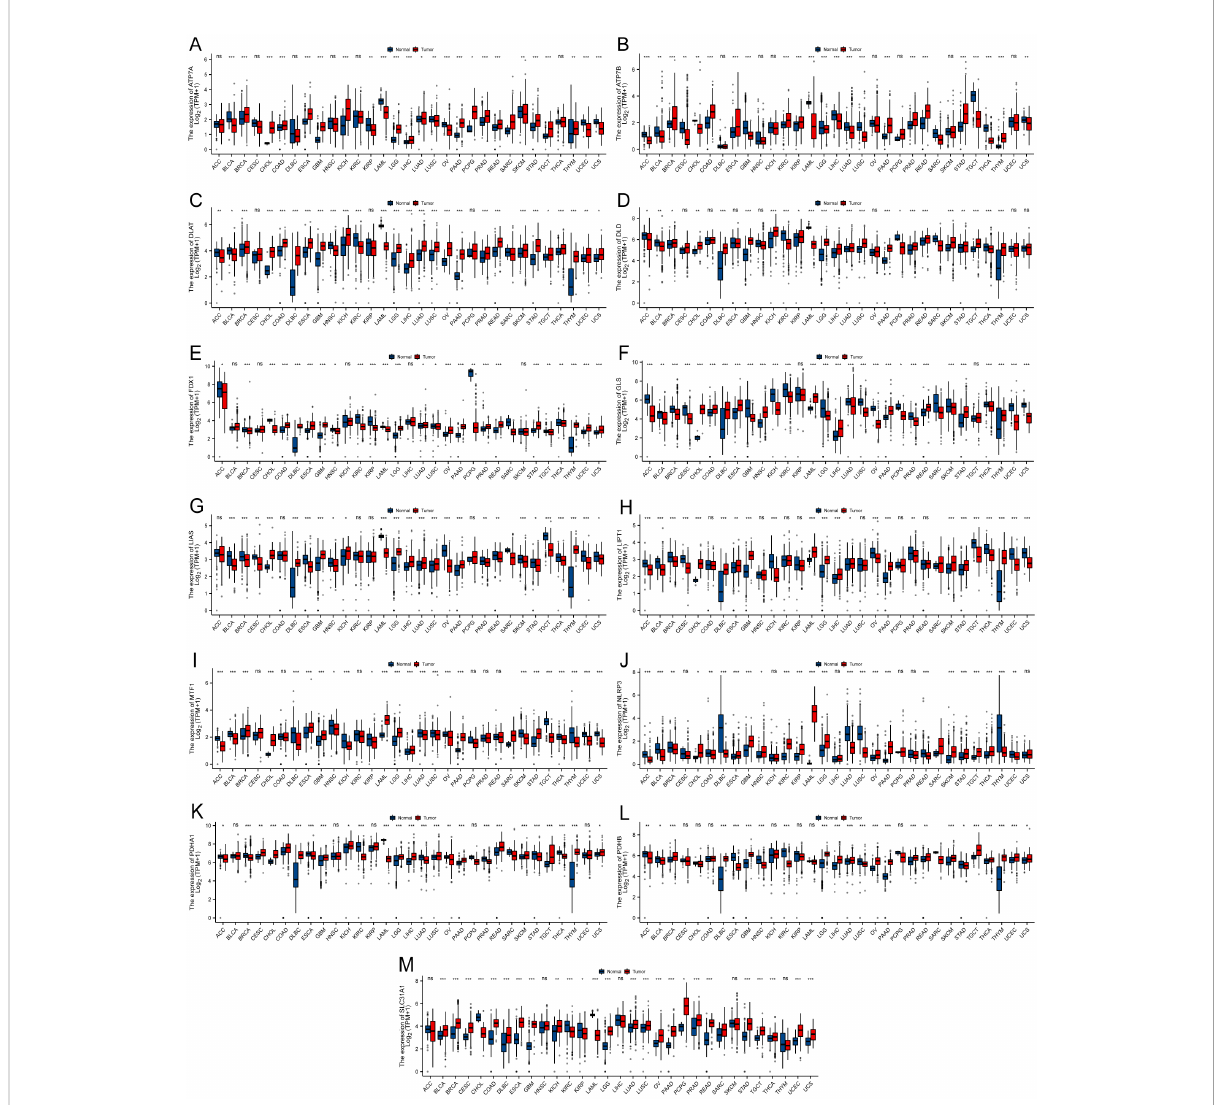
FIGURE 2 Boxplot demonstrating the differential expression of cuproptosis-related genes between cancerous and adjacent healthy tissues. The blue color indicates healthy tissues, and the red color indicates cancerous tissues. (A) ATP7A. (B) ATP7B. (C) DLAT. (D) DLD. (E) FDX1. (F) GLS. (G) LIAS. (H) LIPT1. (I) MTF1. (J) NLRP3. (K) PDHA1. (L) PDHB. (M) SLC31A1 (*P < 0.05; **P < 0.01; ***P < 0.001) No signi fi cance